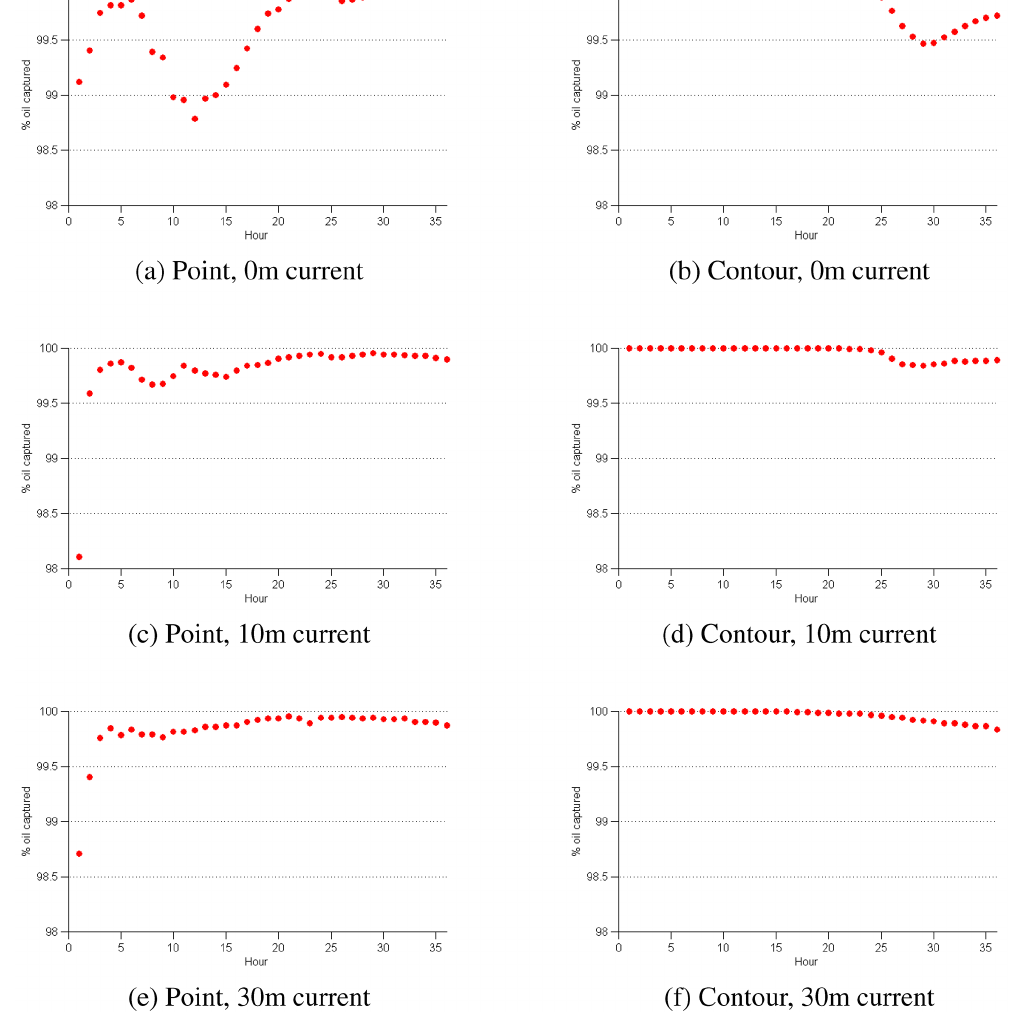
Figure 7. Percentage of oil captured by CranSLIK’s forecast of the slick’s convex hull for the Algeria case (point and contour scenarios), using the current at different depths as the advective